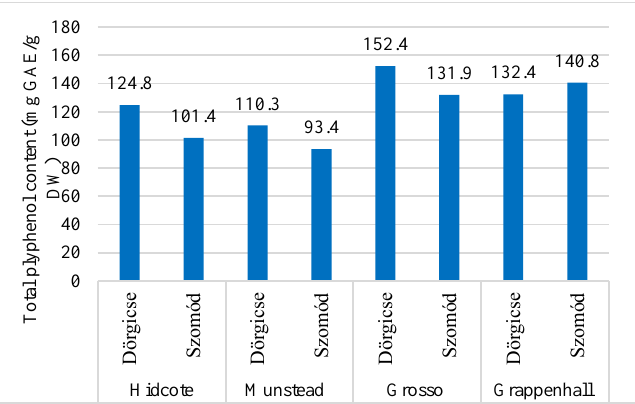
Figure 4. Total polyphenol content (TPC: mg GAE/g DW) of L. angustifolia and L. × intermedia cultivars in Dörgicse and Szomód (2017).